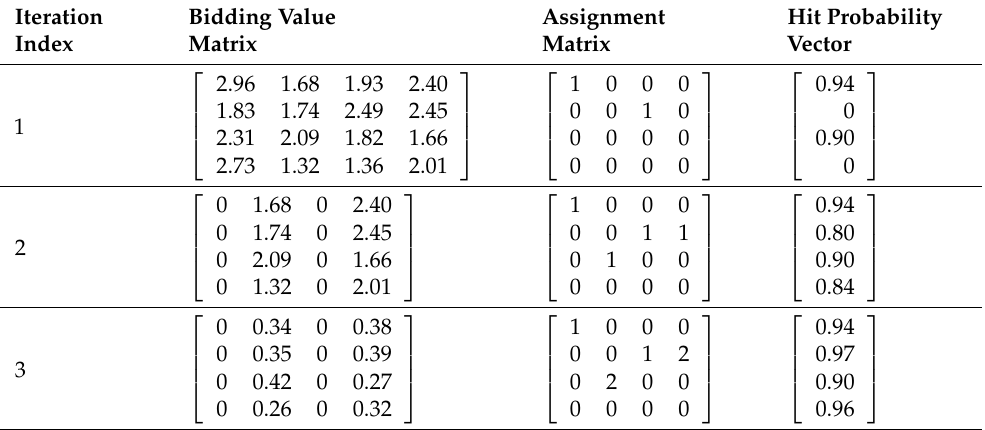
Table 3. Intermediate results of the